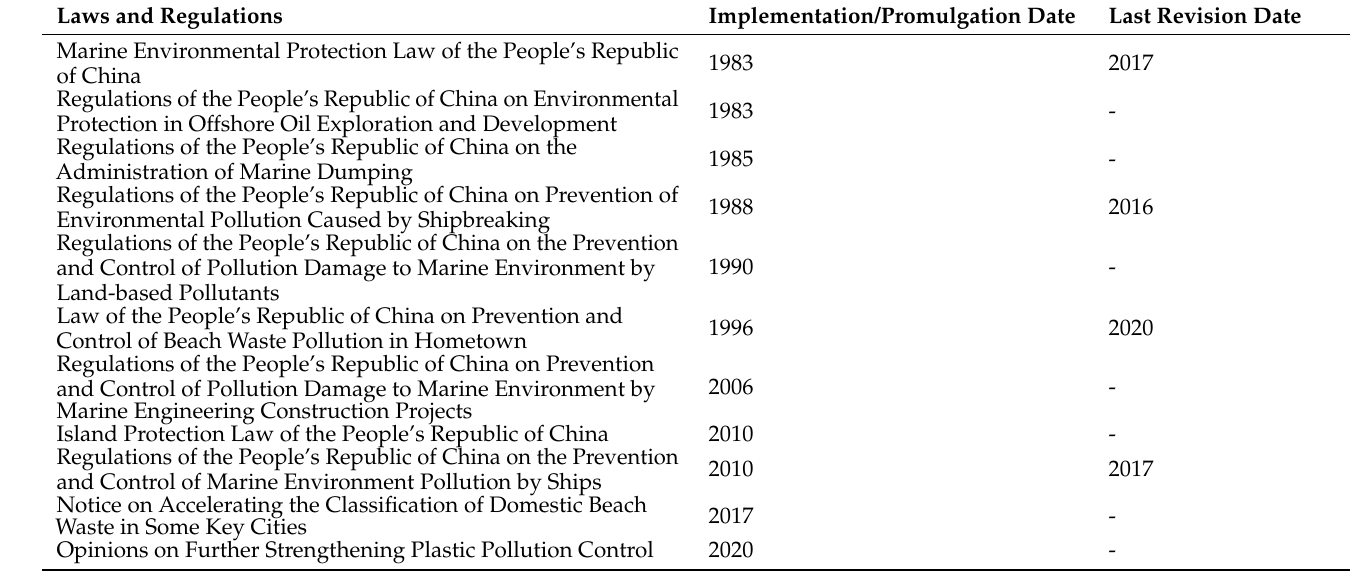
Table 2. Current laws and regulations concerning marine and beach waste management in China.